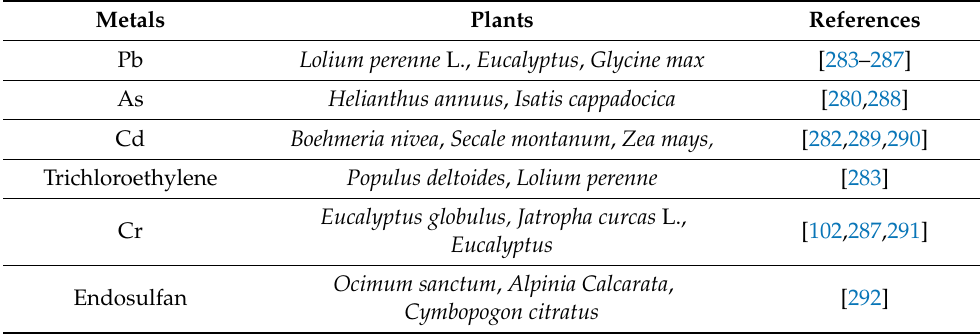
Table 4. List of plants used with nanoparticles to remove